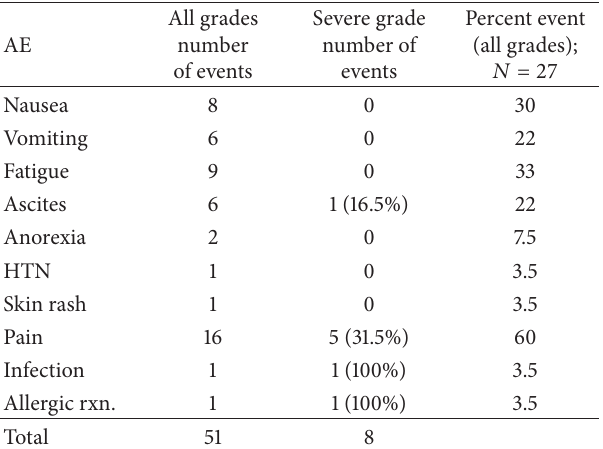
Table 3: Adverse event after DEB-TACE.